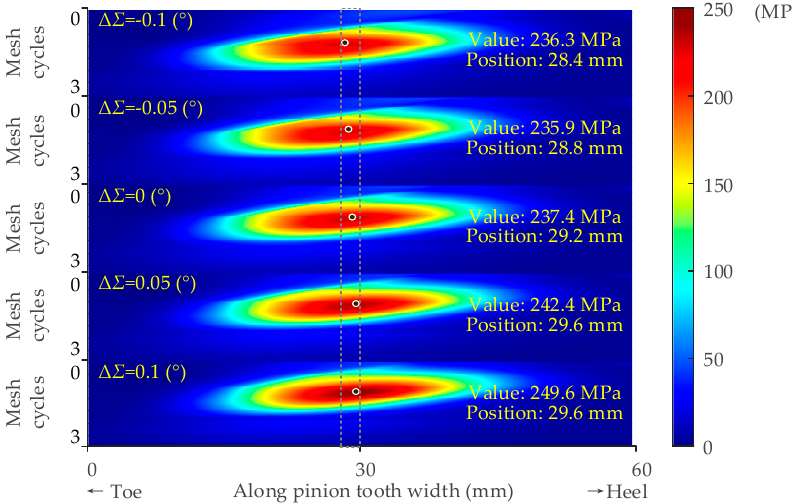
Figure 11. Variation of tooth root stress in three mesh cycles considering the variation of shaft angle error.